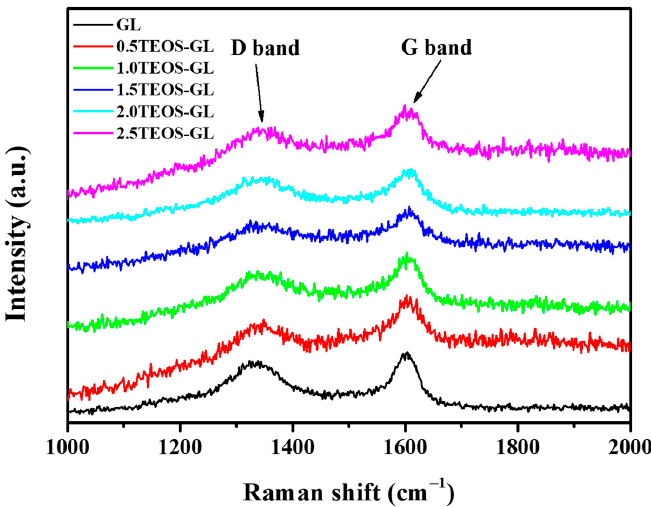
Figure 6. Raman spectra of GL and GL-TEOS-x (x = 0.5, 1, 1.5, 2, and 2.5). Table 1. Comparison of the product quantity, theoretical carbon content, and compressive strength of di ff erent carbon materials.